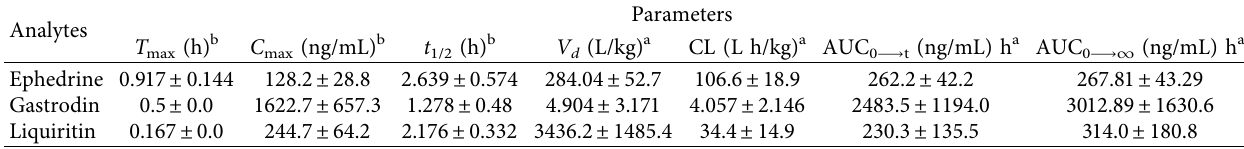
Table 5: Mean pharmacokinetic parameters of ephedrine, gastrodin, and liquiritin in rat plasma after intragastric administration of Banxia Baizhu Tianma Tang solution of 16.6mL/kg, equivalent to 28 mg/kg of ephedrine, 10mg/kg of gastrodin, and 9mg/kg of liquiritin, re- spectively (mean ± SD, n �